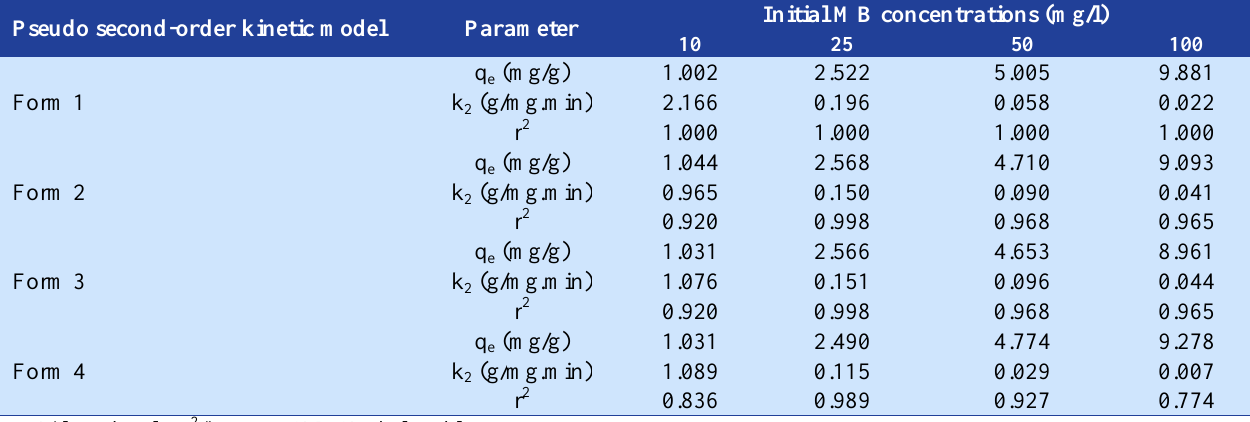
Table 5. kinetic parameters of methylene blue (MB) adsorption onto acid-activated spent tea (AAST) surfaces using linear regression approach Pseudo second-order kinetic